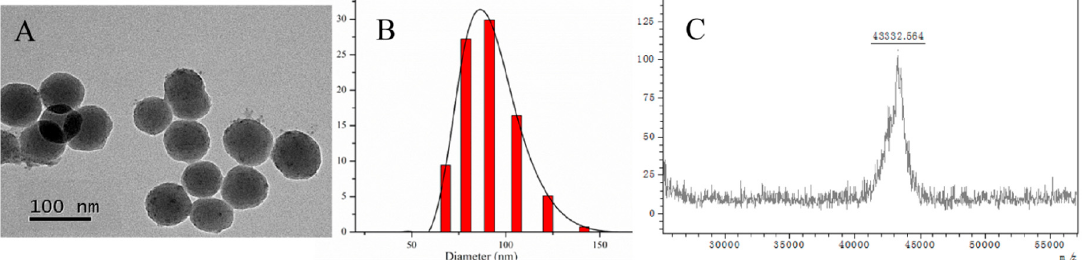
Figure 2. The TEM image ( A ) and size distribution ( B ) of human serum albumin functionalized silicon dioxide nanoparticles(nano-SiO 2 -HSA), and the molecular mass of horseradish-peroxidase-labeled naproxen (HRP-naproxen) measured by MALDI/TOF MS